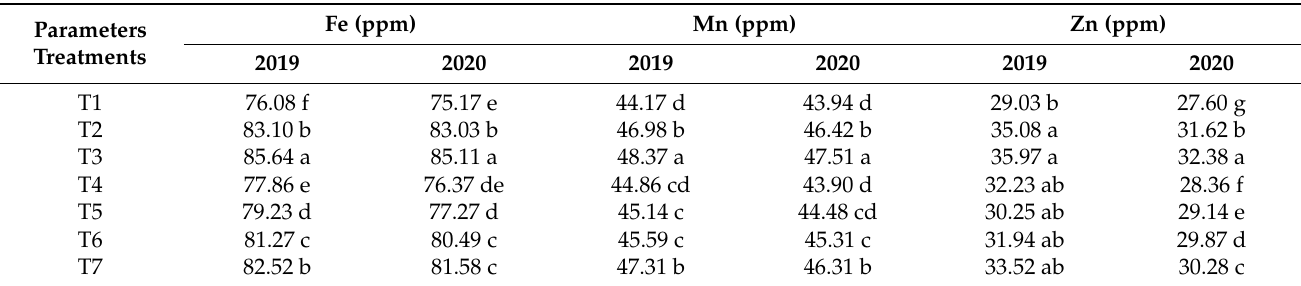
Table 4. Influence of iron (nano, sulfate, and chelated) foliar spray on Fe, Mn, and Zn (ppm) contents of Washington navel orange trees during 2019 and 2020 experimental seasons.